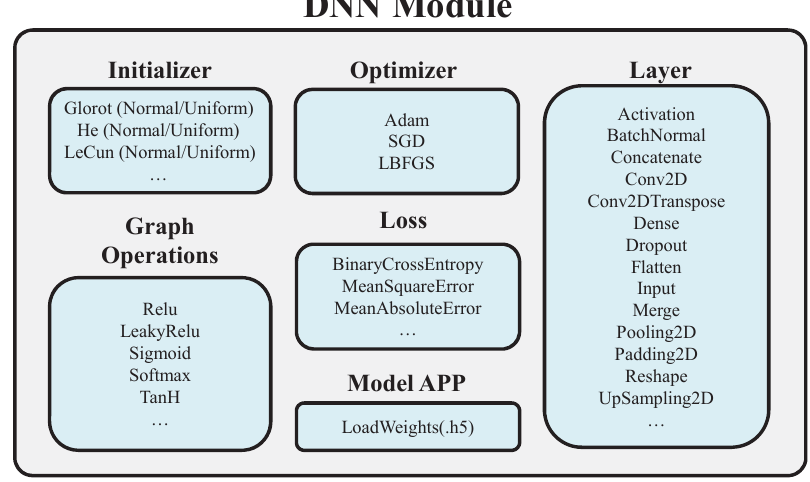
Figure 5. The DNN (deep neural network) module.